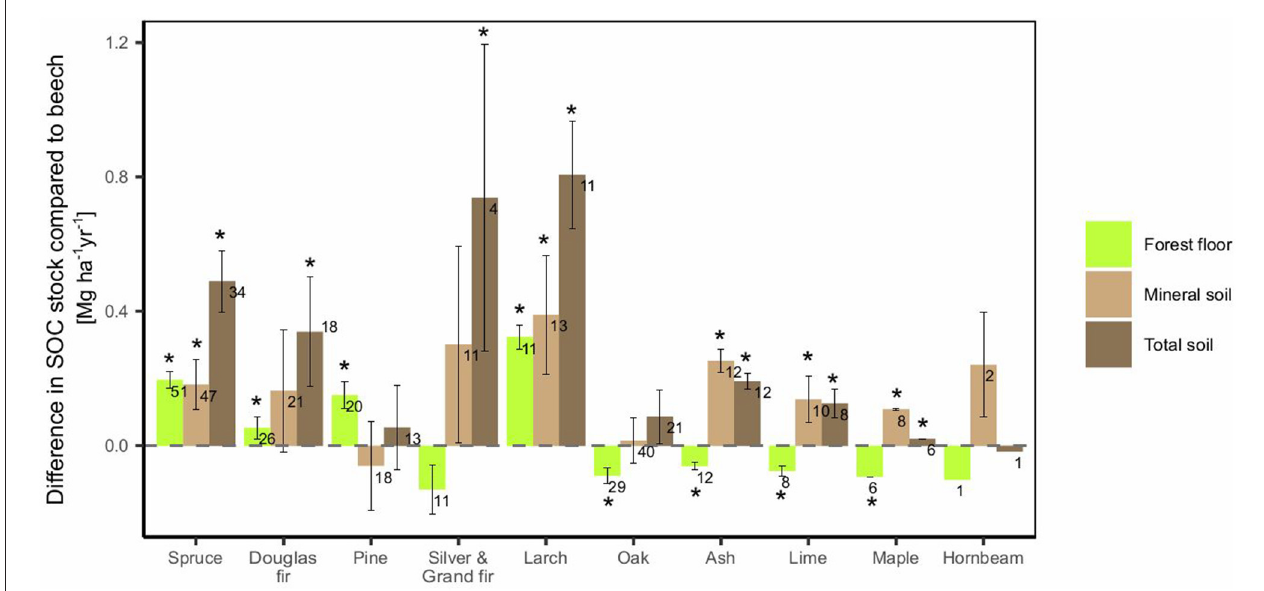
FIGURE 4 | Average absolute annual differences of SOC stocks of monoculture stands compared to beech monoculture. Numbers next to the bars are the number of observations. Error bars show the standard error. Asterisks indicated significant differences compared to beech monoculture. Note that in some cases the difference for the total soil is not the sum of those for the forest floor and mineral soil, since not all studies included observations for both layers.